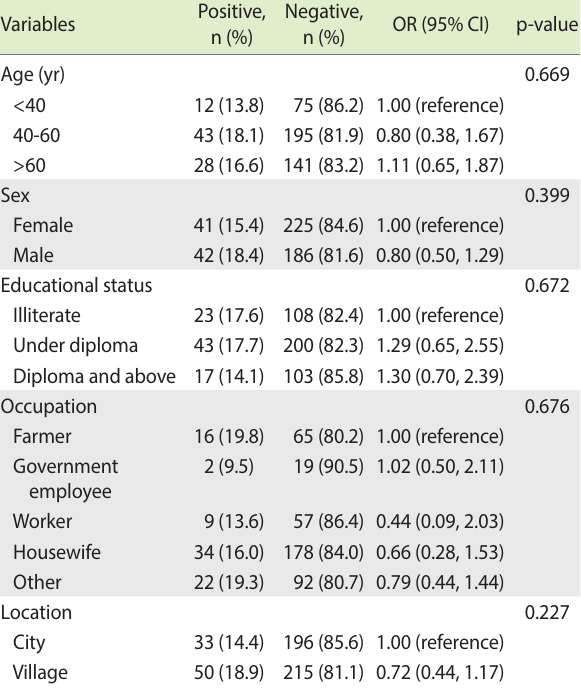
Table 1. Prevalence of infections with intestinal parasites in patients receiving immunosuppressive drugs in Guilan Province, northern Iran, according to demographic factors